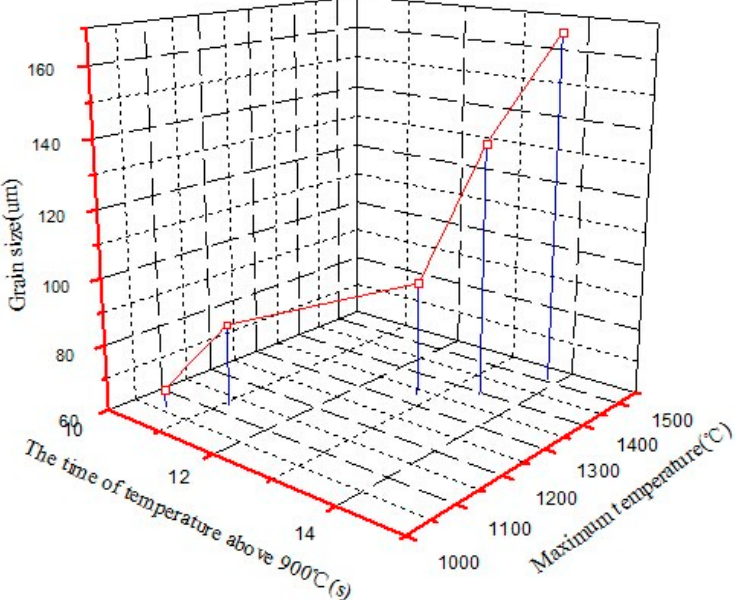
Figure 11. The relationship between the grain size and the staying time above 900 °C and the highest temperature experienced. temperature